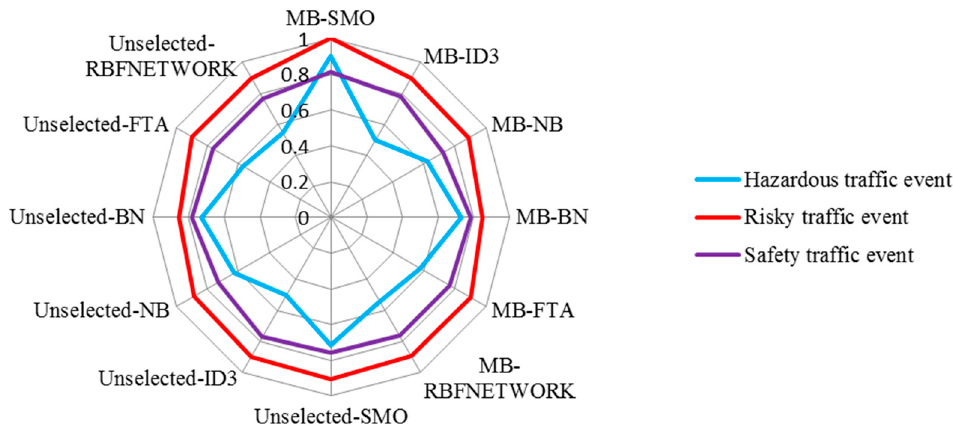
Figure 13. The radar map of the three traffic event styles.